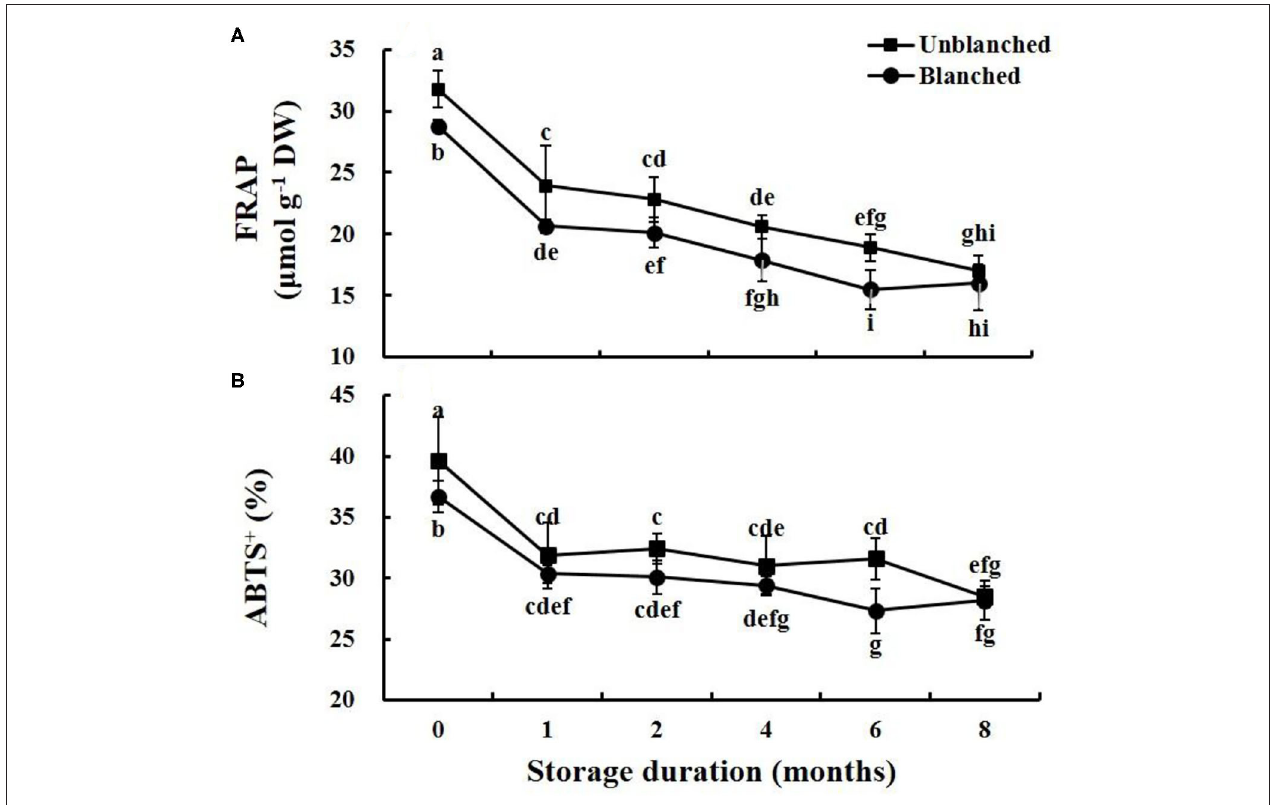
FIGURE 4 | Evolution trend of antioxidant capacity levels in baby mustard lateral buds during frozen storage at − 20 ◦ C. (A) FRAP; (B) ABTS + . Unblanched represents no blanching before freezing; Blanched represents blanching before freezing. Values not sharing the same letter are significantly different at p < 0.05.